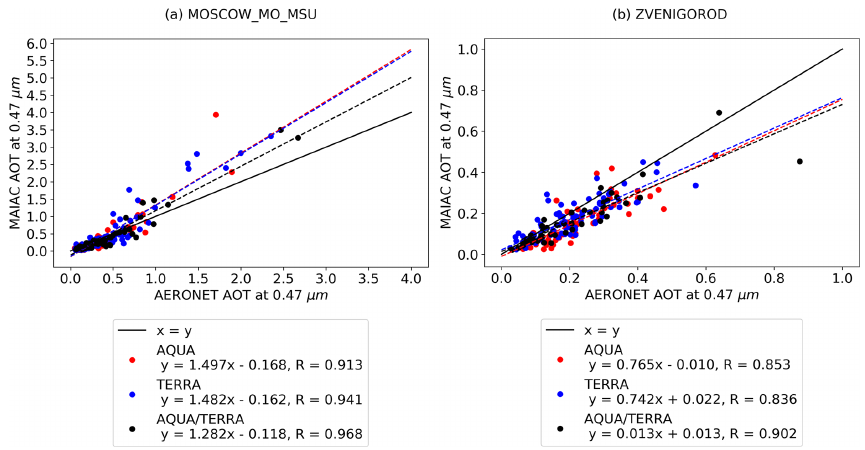
Figure 2. Correlations between MAIAC AOT at 0.47µm and AERONET AOT at 0.47µm for the Moscow_MSU_MO and Zvenigorod AERONET sites for Terra, Aqua, and their joint overpasses within 1h (Aqua/Terra). Comment: the absence of high AOT values at the Zvenigorod site is explained by technical problems with the instrument and the absence of the AERONET data at level 2, version 3 in 2010, when intensive forest fires took place.